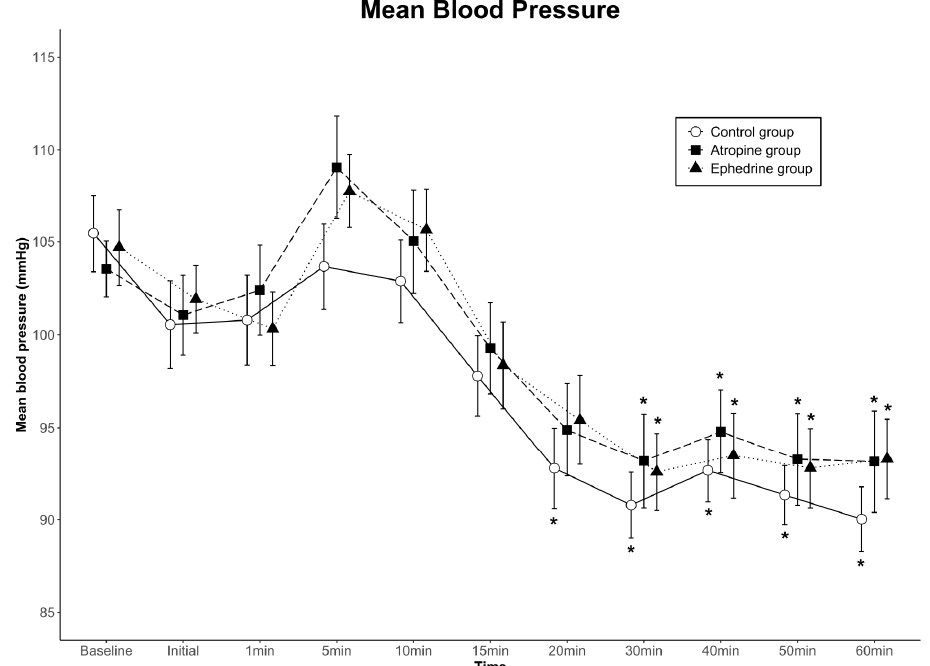
Figure 3. Mean arterial blood pressure values for the three groups. Data are presented as mean ± standard error. There were no significant differences among the groups, and no significant interactions with time-by-group. * p < 0.05 compared to baseline within group by one-way ANOVA. Baseline, baseline value before spinal anesthesia; Initial, immediately before the administration of dexmedetomidine; 1–60 min, 1–60 min after the administration of dexmedetomidine.